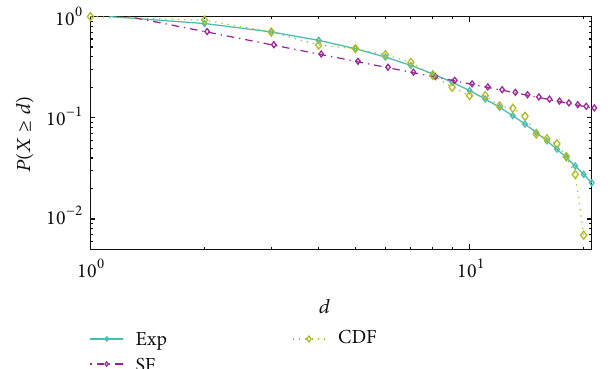
Figure 5: Exponential (Exp) and scale-free (SF) fits for the CDF of G 50 .